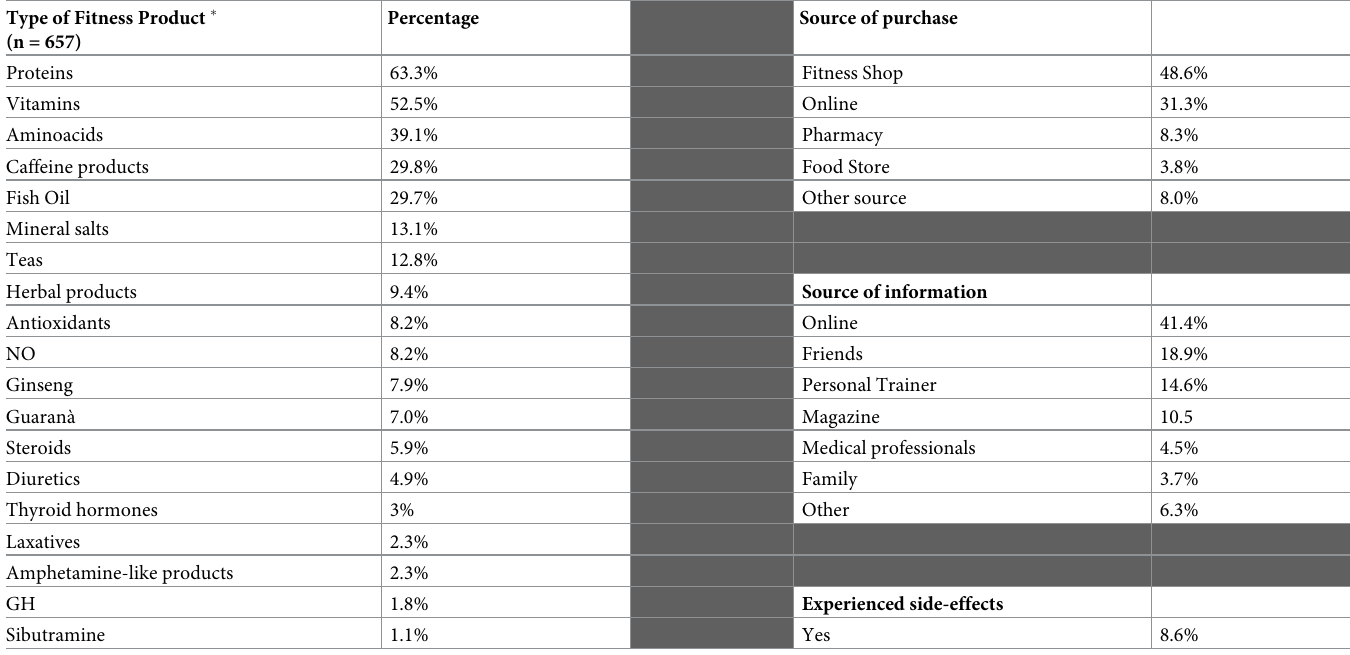
Table 5. Use of fitness supplements: Type, source of purchase and source of